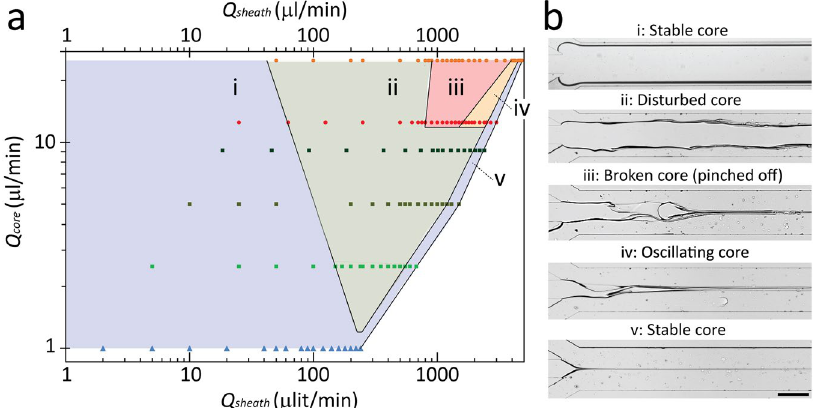
Figure 2. ( a ) Flow map of stable, disturbed, broken (pinched-off), and oscillating core regimes with respect to the flow rates of core and sheath flows, and ( b ) Snapshot images of corresponding flow regimes at Q core = 12.5 µ l/ min: (i) ‘stable core’, Q sheath = 62.5 µ l/min, (ii) ‘disturbed core’, Q sheath = 625 µ l/min, (iii) ‘broken core’, Q